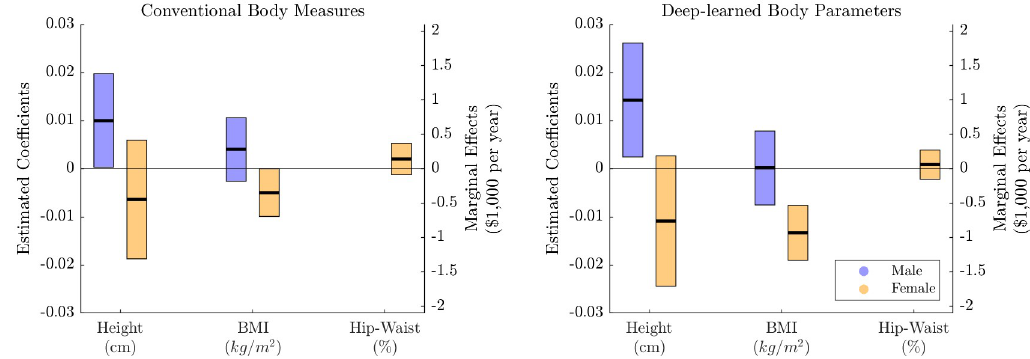
Fig 1. Summary of the estimation results for family income equation. Estimated coefficients and bootstrapped 90% confidence bands are reported. The left panel presents results from the conventional body measures and the right panel reports results from the deep-learned body parameters through the graphical